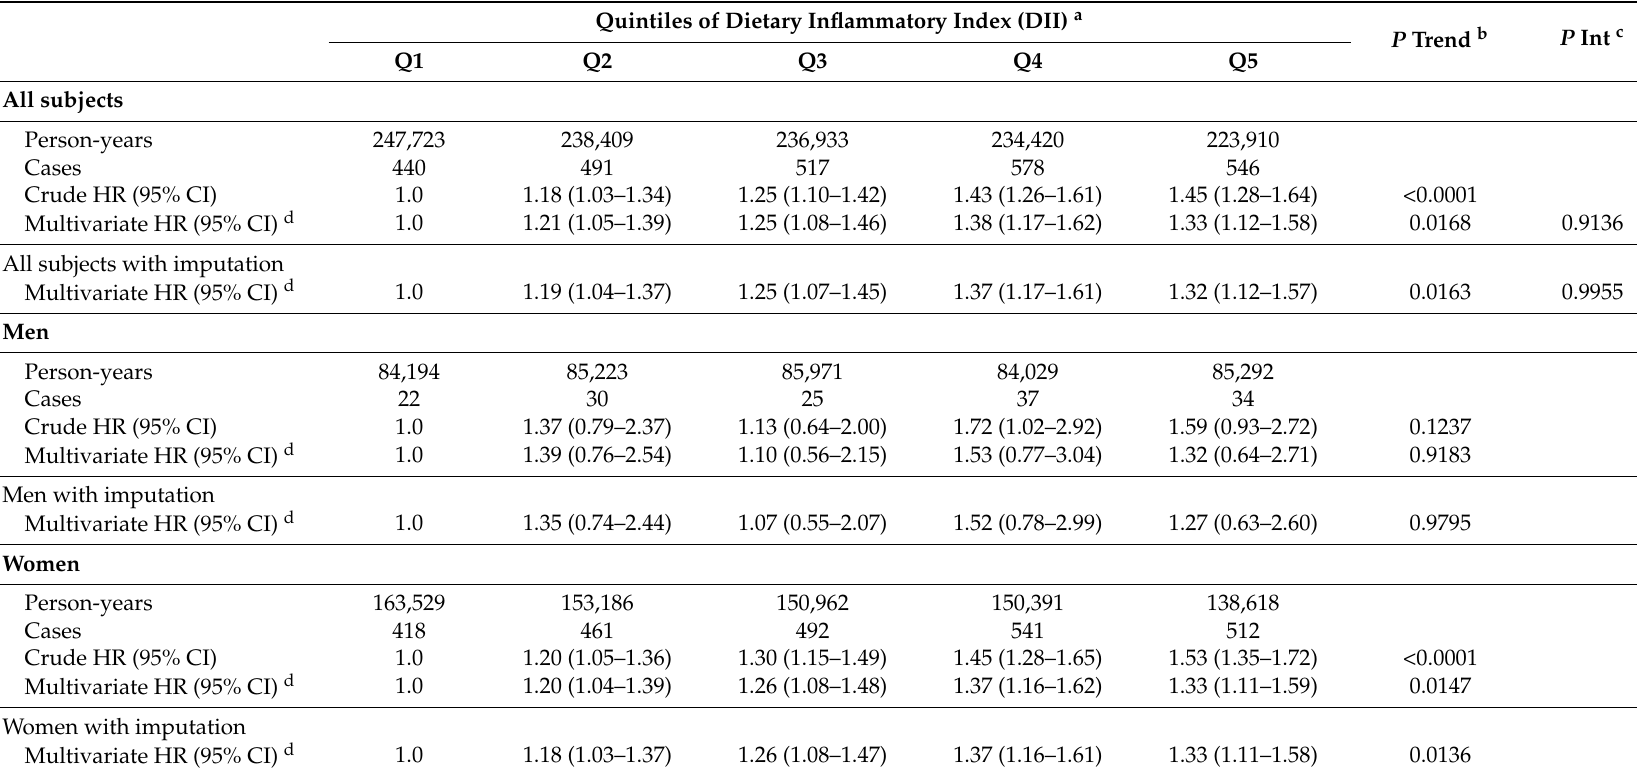
Table 2. Cox Proportional Hazard Ratios (HRs) (95% Confidence Intervals (CIs)) for osteoporosis risk by quintiles of DII score for all participants in the KOGES cohort,